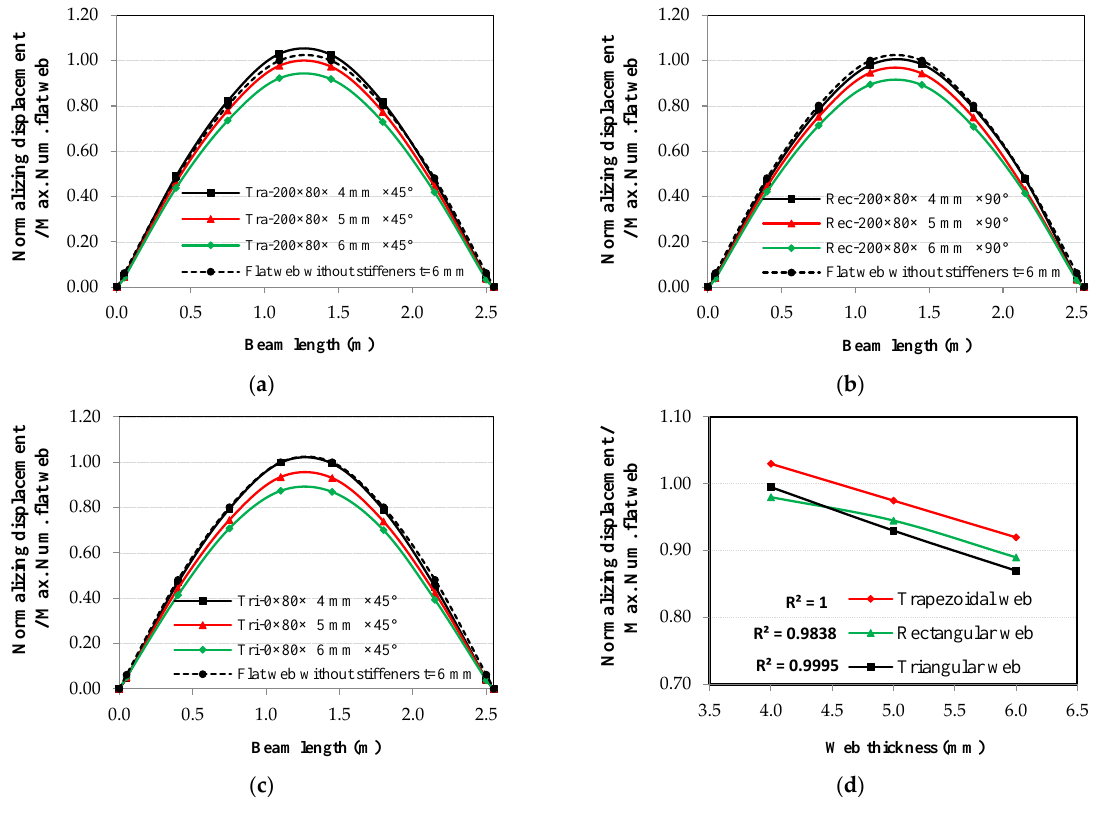
Figure 9. Thickness effect on the relationship between normalized displacement and beam length for the 1st mode shape: ( a ) trapezoidal web, ( b ) rectangular web, ( c ) triangular web, and ( d ) thickness effect at the 1st mode shape.